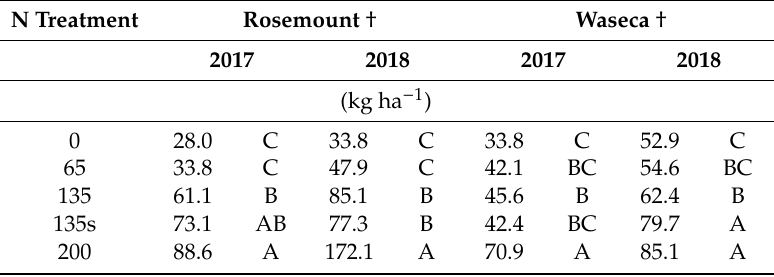
Table 4. Residual soil inorganic N (N min ) by sweet corn N treatment at pennycress seeding at Rosemount and Waseca, MN in 2017 and 2018 from 0–60